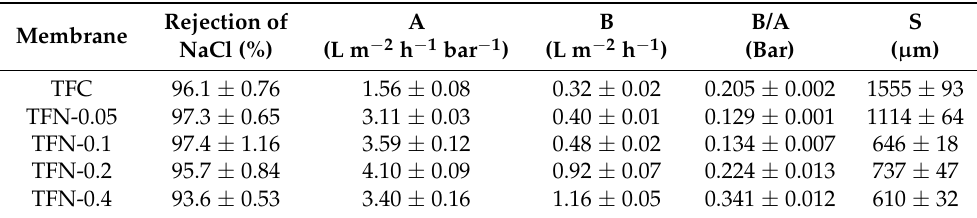
Table 1. Salt rejections (R), intrinsic properties and membrane structural parameters (S) of the TFC and TFN